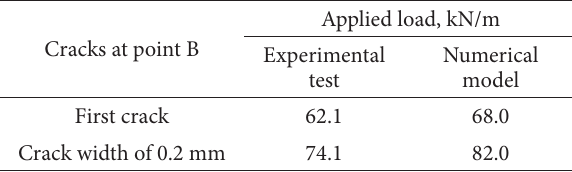
Table 4. The applied load depending on the cracks at point B Cracks at point